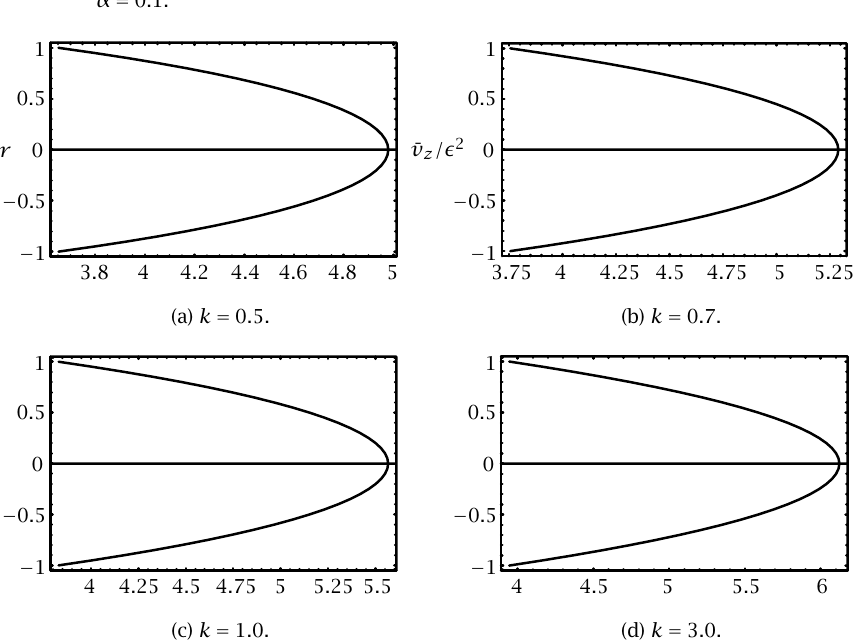
Figure 6.11 . The effect of the permeability parameter k on the mean- velocity distribution and reversal flow at Re = 1 . 0, (∂P/∂z) 2 = 10 . 0, and α = 0 .